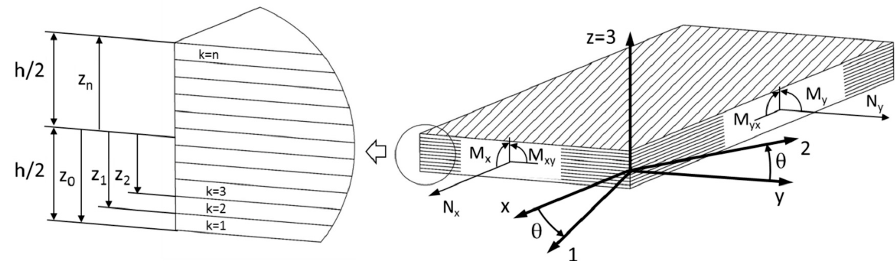
Figure A1. Multidirectional laminate with coordinate notation of individual plies, subjected to forces and moments per unit length.